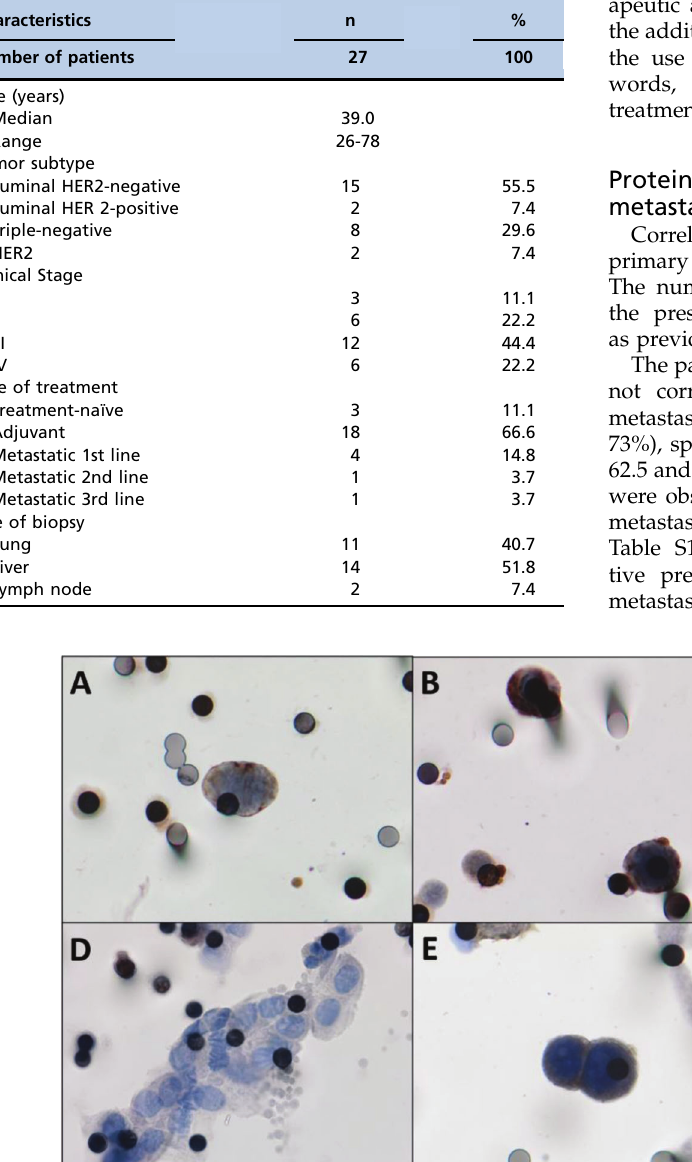
Table 1 - Clinical and pathological characteristics of the patients.